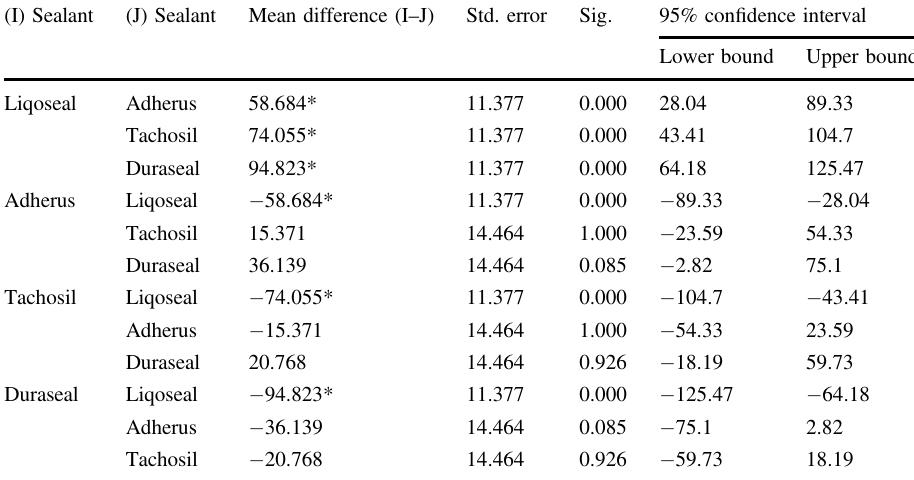
Table 1 Differences in mean burst pressure between sealants in the cranial setup adjusted for multiple comparisons with post- hoc Bonferroni correction